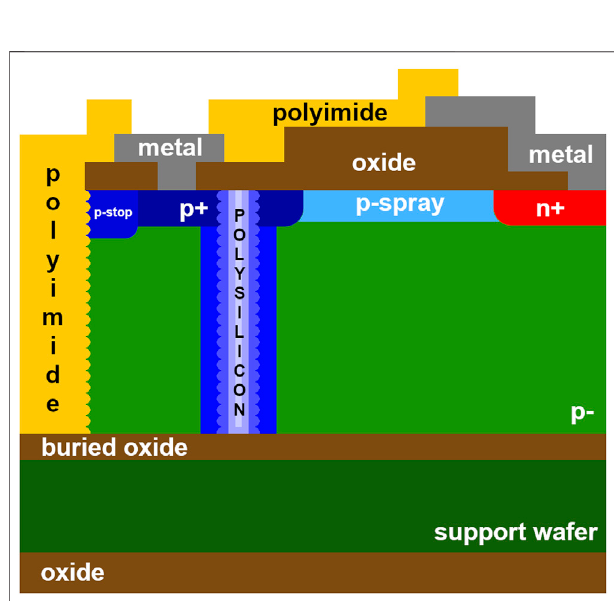
FIGURE 6 | Complete radial cross-section of a sensitive volume fabricated with 3D